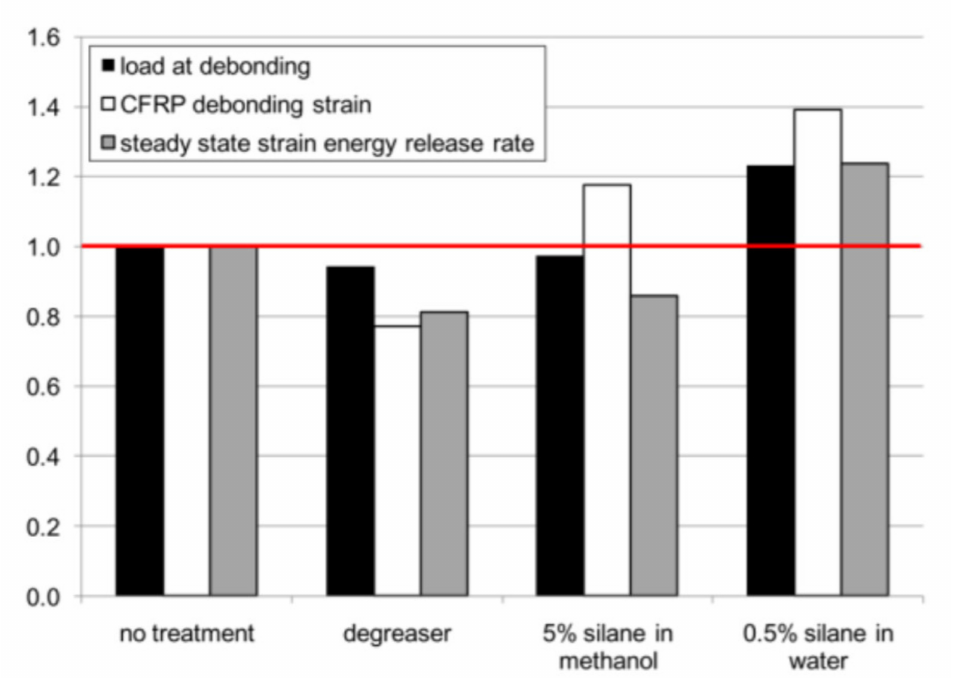
Figure 8. Effect of treatments normalized to behaviour of specimens having no treatment [50]; used with permission from Composite Structures, Elsevier,